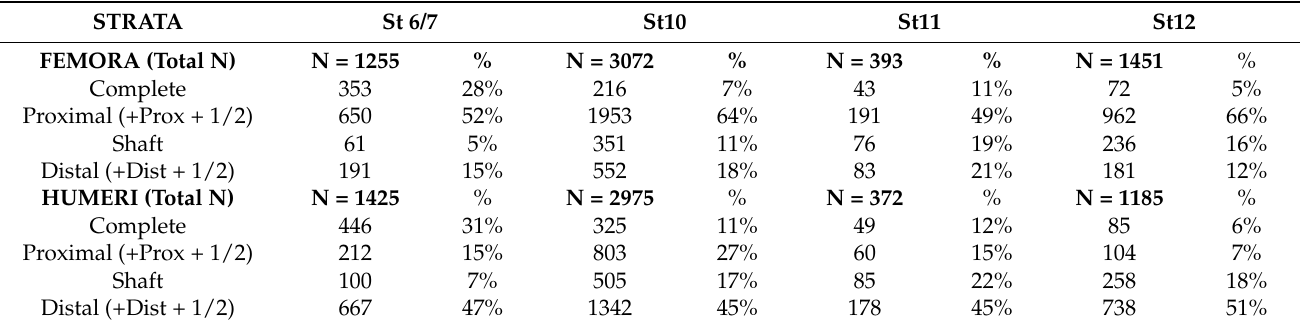
Table 2. Frequency of long bone (femora and humeri) portions and complete elements from four strata of Wonderwerk Cave site according to Marin-Monfort et al.